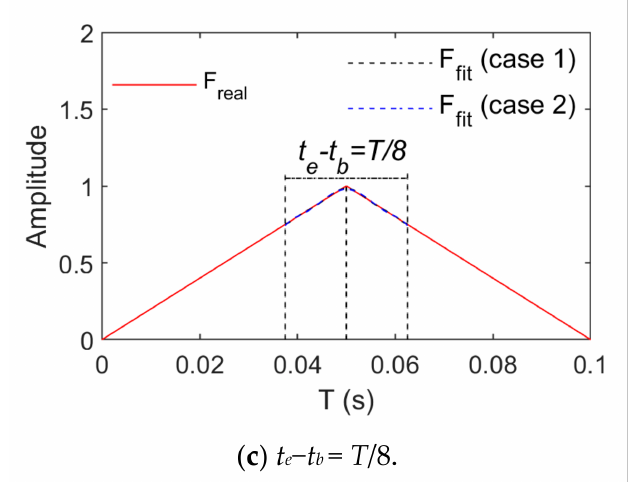
Figure 10. Comparison between real and fitting values of triangular wave loads ( f = 5